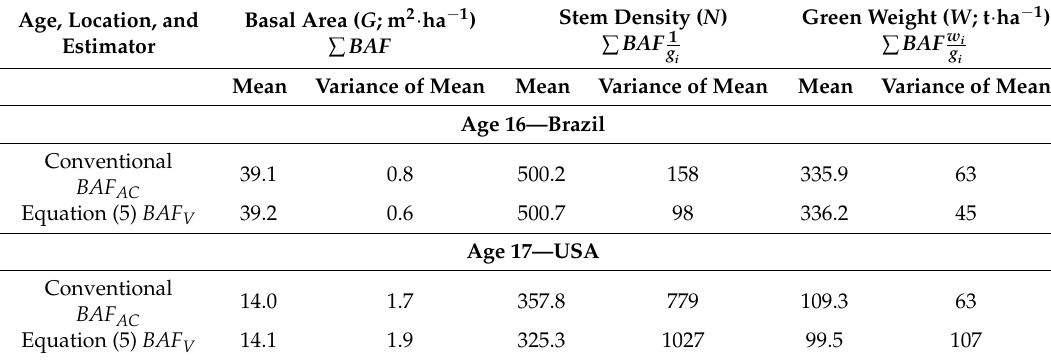
Table 2. Estimates and efficiencies of the point sampling estimators obtained from repeated sampling using a BAF AC = 4 for basal area, stem density, and green weight per